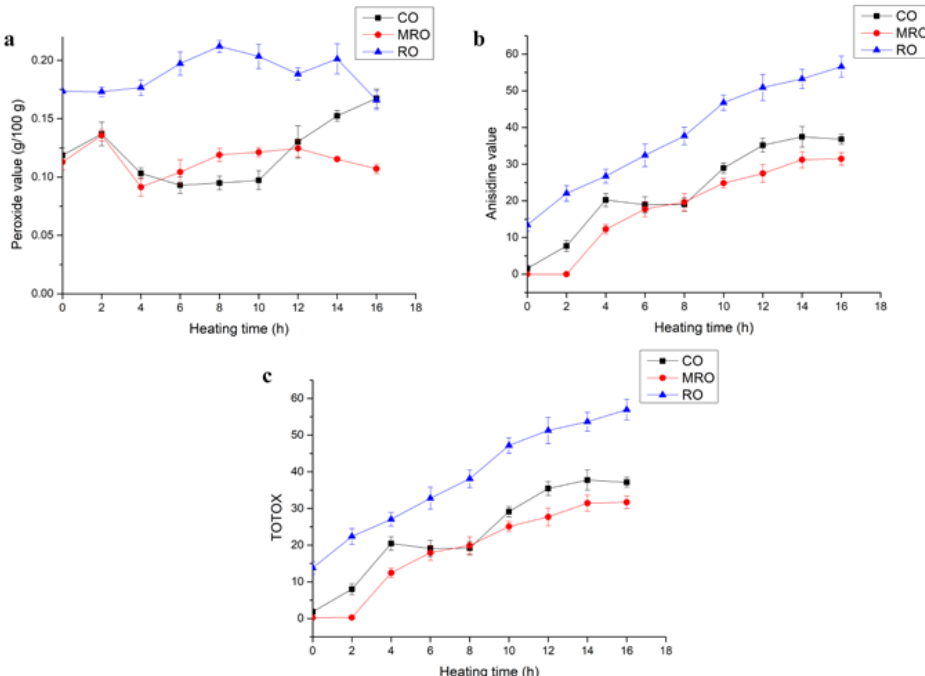
Figure 4. Changes in the ( a ) PV, ( b ) p -AV, and ( c ) TOTOX values of three kinds of camellia oil during heating. TOTOX: total oxidation values.